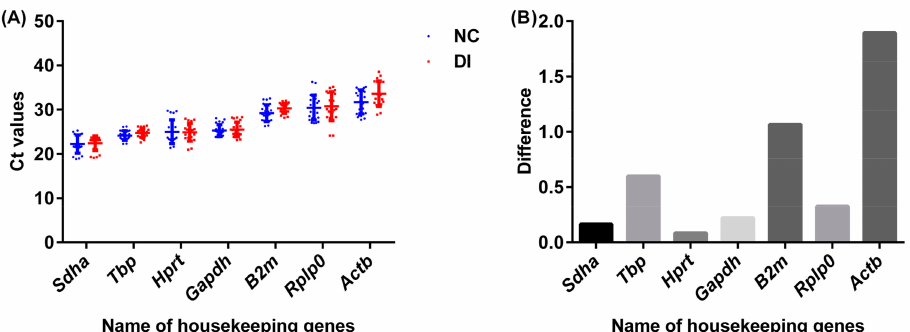
Figure 5. mRNA expression levels of seven housekeeping genes in normal and diarrhea-rat organs including colon, kidney, stomach, spleen, and liver. The expression was detected in 60 ng of RNA by using qRT-PCR. ( A ) Graphical representation of absolute Cq values for each gene analyzed in tissues collected from the normal rats (NC) and diarrhea-rats (DI) induced by senna extract. ( B ) The difference of mean Cq values for each gene between the normal rats and the diarrhea-rats. A line across the box depicts the median. Whiskers represent the maximum and minimum